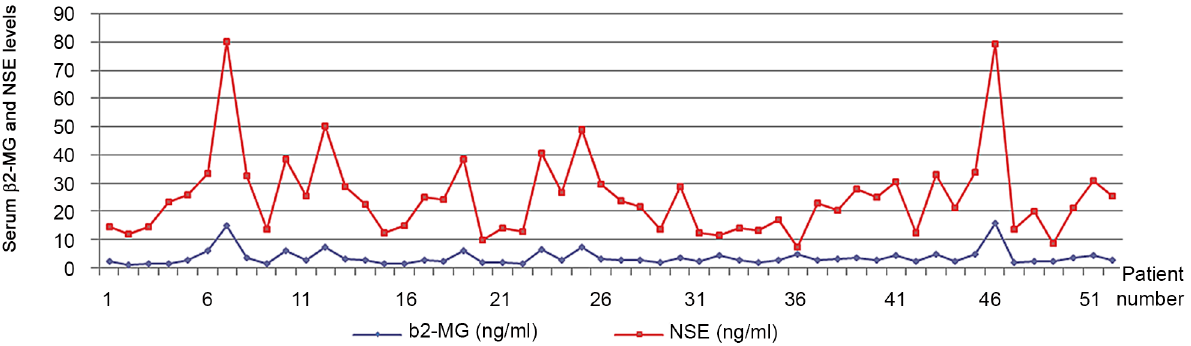
Figure 3. Correlation between NSE level in patients with previously untreated MM and the amount of the prognostic indicator b 2- MG.